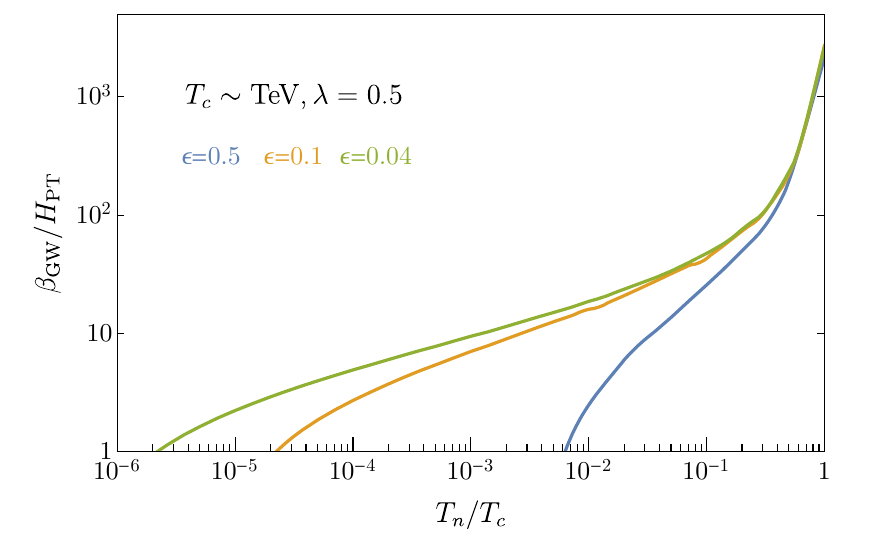
Figure 6. Nucleation temperature T n /T c (left panel) and β GW /H PT (right panel) as a function of (cid:15) for different choices of N and fixed λ = 0 . 5 , T c ∼ O ( TeV ) .